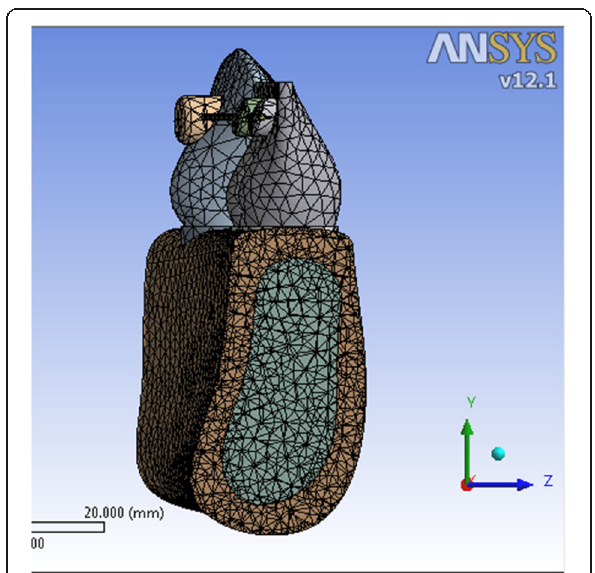
Fig. 2 Meshed model 2 showing the inclination of the anterior teeth at 90° to the horizontal